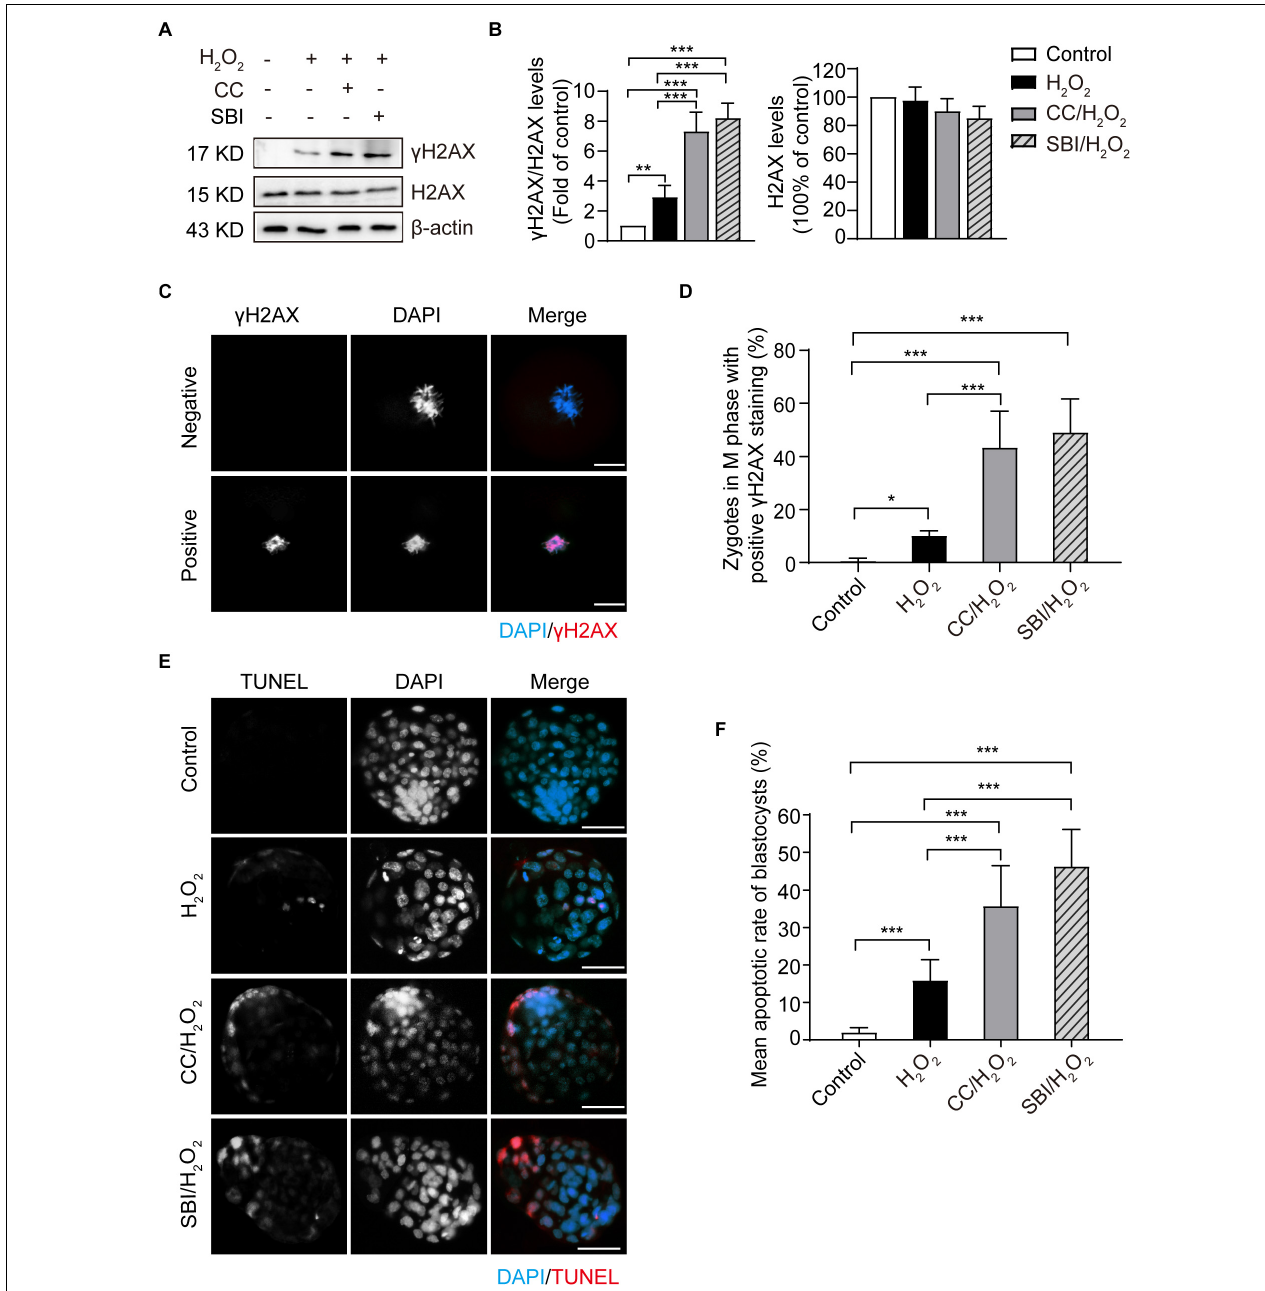
FIGURE 6 | Inhibition of AMPK activity aggravated oxidative stress-induced DNA damage in zygotes and apoptosis in blastocysts. CC, Compound C; SBI, SBI-0206965. (A) Representative data of γ H2AX levels in mouse zygotes in the M phase under oxidative stress. (B) Quantification of data from Figure 4A ( n = 3). (C) γ H2AX immunostaining (red) in zygotes in the M phase under oxidative stress. Nuclei were stained with DAPI (blue). Scale bar = 20 µ m. (D) Quantification of zygotes at M phase with positive γ H2AX immunostaining. More than 60 zygotes in each group were counted in each experiment ( n = 6). (E) Detection of blastocyst apoptosis (red). Nuclei were stained with DAPI (blue). Scale bar = 100 µ m. (F) Quantification of blastocyst apoptotic rate in the control group ( n = 36), H 2 O 2 -treated group ( n = 33) and Compound C/H 2 O 2 -treated group ( n = 29), and SBI-0206965/H 2 O 2 -treated group ( n = 19). Results in (B,D,F) were analyzed by one-way ANOVA and Tukey’s test. * p < 0.05; ** p < 0.01; *** p < 0.001. Error bars: